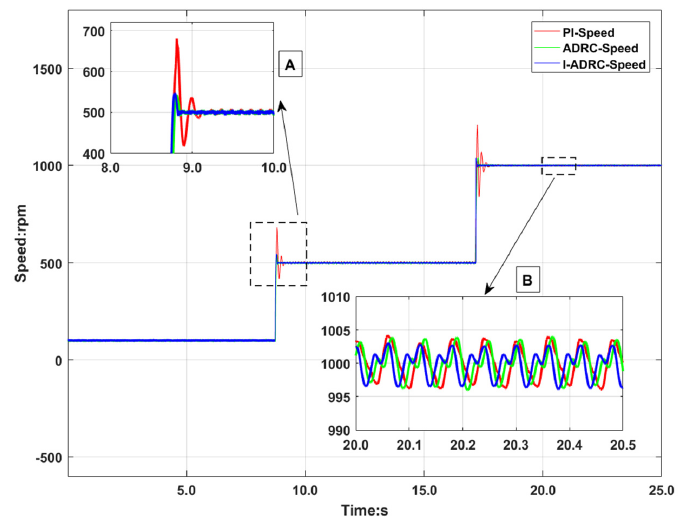
Figure 9. No load speed regulation test curve.